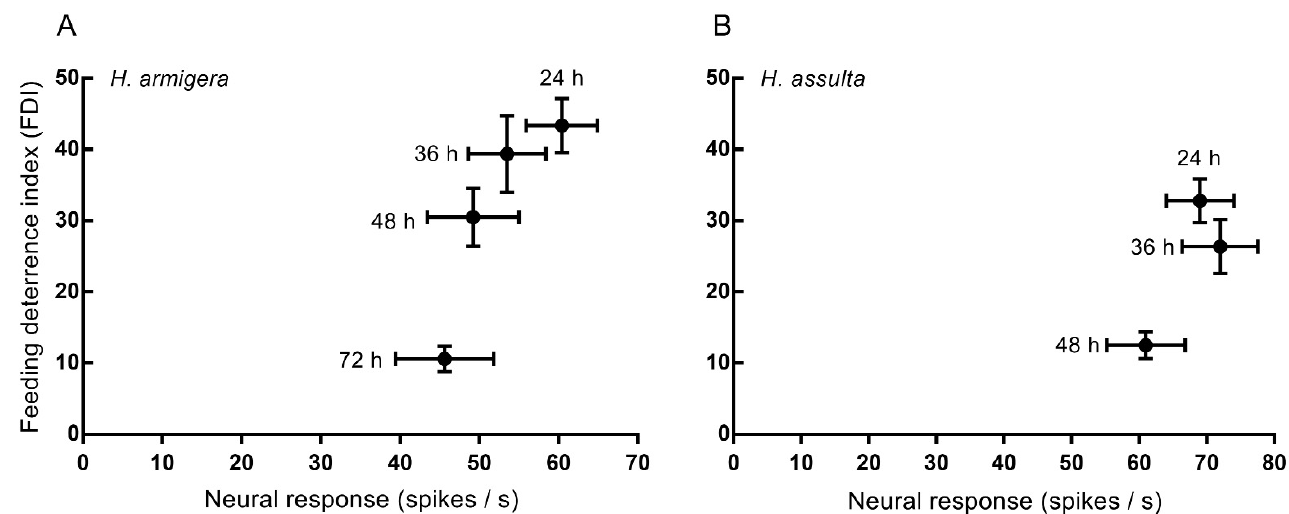
Figure 5. Relationship between electrophysiological and behavioral responses in H. armigera and H. assulta caterpillars . Plot of feeding deterrent index (FDI) as a function of electrophysiological response strength upon stimulation with a 10 mM solution of strychnine in ( A ) H. armigera , ( B ) H. assulta caterpillars exposed for the durations indicated (24 h, 36 h, 48 h, or 72 h). Control solution was 2 mM KCl. Errors bars represent s.e.m.